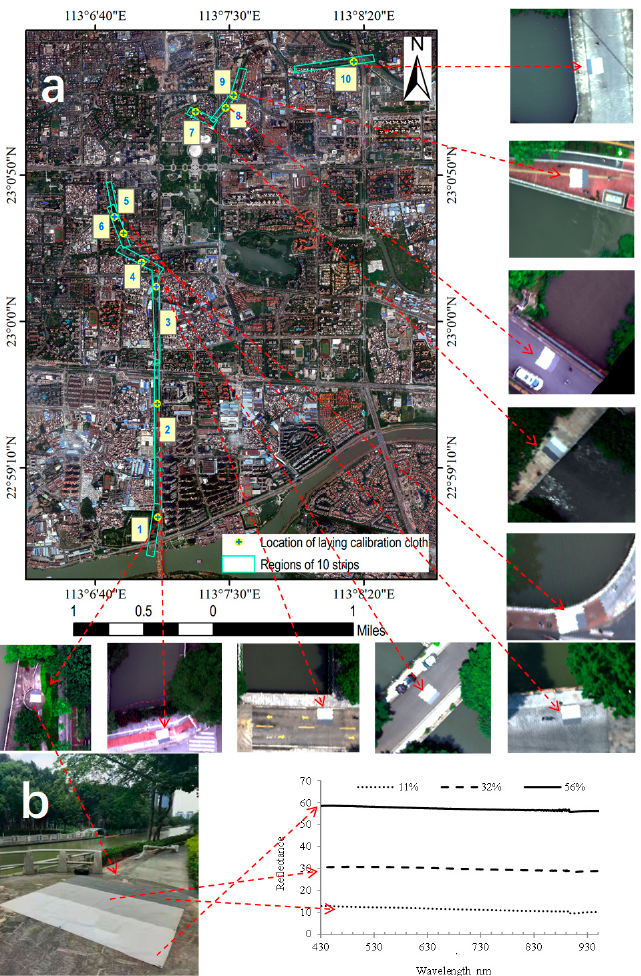
Figure 2. Distribution of 10 strips and the information of radiometric calibration cloth. ( a ) The radiation calibration cloth is laid for each strip, and three reflectivity calibration cloths are laid. The cloth is laid in a flat and unobstructed place with an area of 3 × 3 m. ( b ) This is the standard reflectance of the calibration cloth. They are 11%, 32%, and 56%, respectively. In the later calibration, they are selectively used according to the field